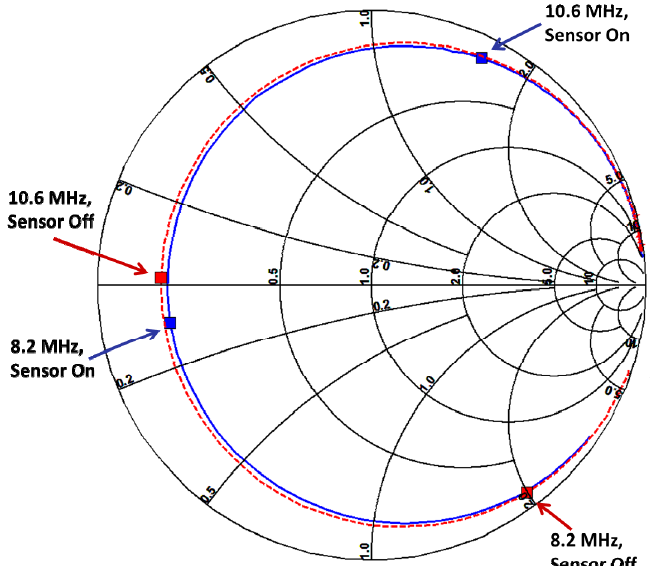
Figure 8. Smith chart showing measured resonance frequency for the parallel plate type EAS tag equipped with a tilt sensor that is in “on” state, blue (solid) graph, and “off” state, red (dashed)